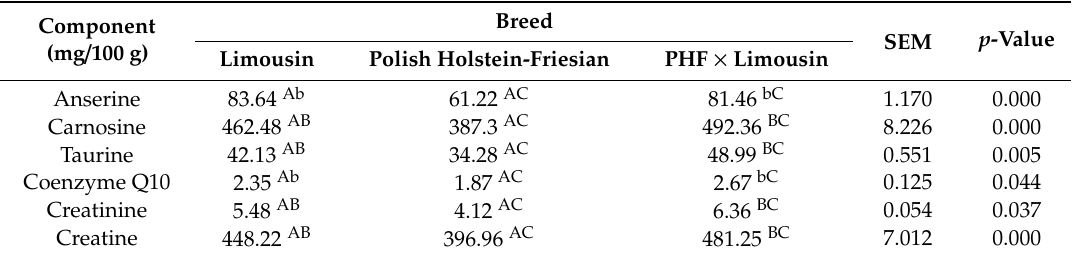
Table 6. The influence of breed on bioactive protein fraction component levels in muscle